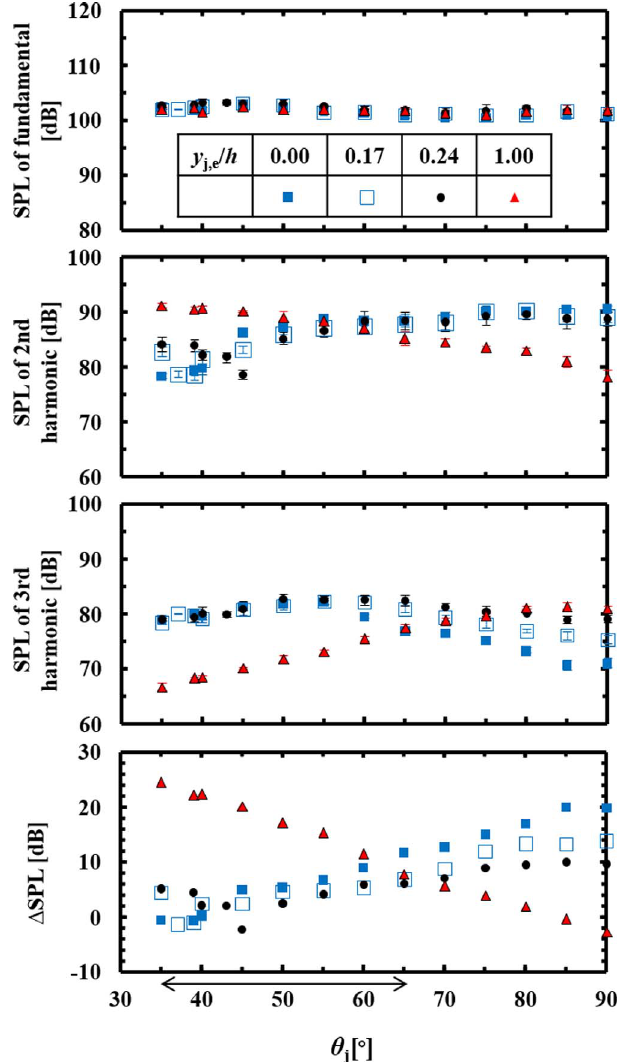
Figure 12. Variations of harmonic structure with jet angle, where lip-to-edge distance and fl owrate were fi xed to the actual blowing conditions shown in Table 1 ( l / h = 5.6, Q = 16 L/min). Arrow shows practical range.